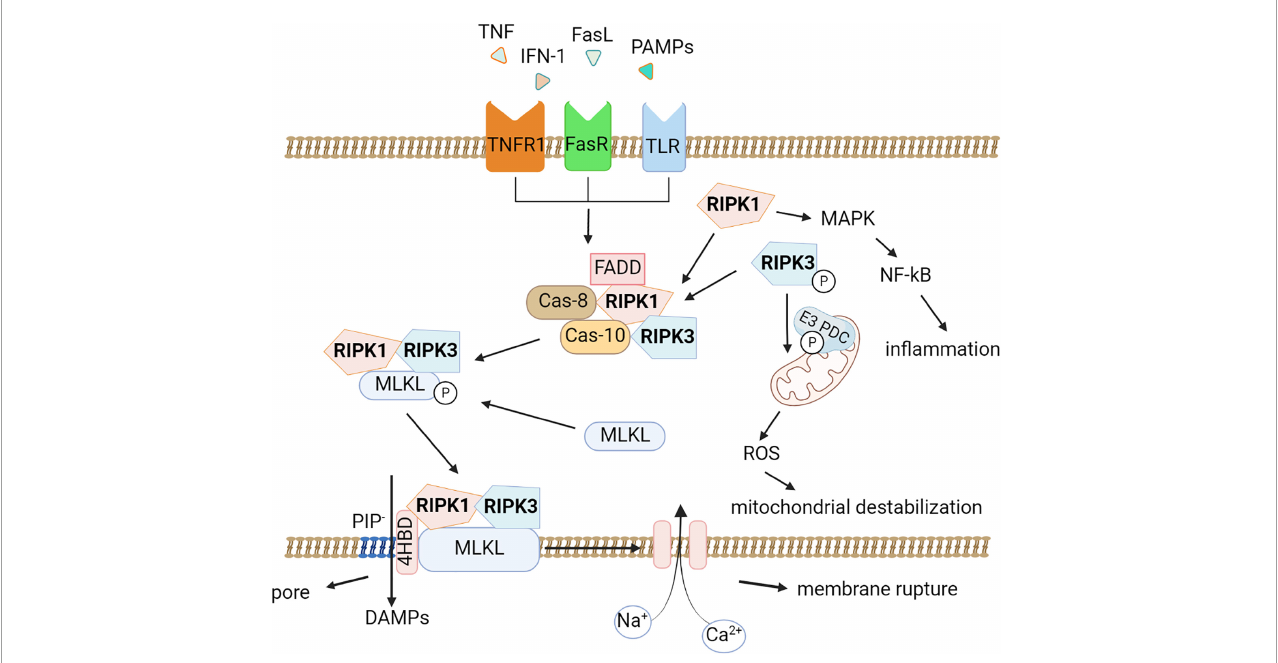
FIGURE1 Molecular pathways of necroptosis. Activation of the tumor necrosis factor receptor (TNFR1), death receptors, Toll-like receptors triggers necroptosis. An oligomeric complex including RIPK1, Fas-associated death domain protein (FADD), caspase-8, and caspase-10 is formed and if caspase-8 activity is absent, RIPK1 recruits and phosphorylates RIPK3 to form a ripoptosome complex. Further the RIPK1/RIPK3 complex recruits and phosphorylates MLKL, thereby forming necrosomes. MLKL forms pores in the plasma membrane through an interaction between a positively charged site in the 4-helical bundle domain (4HBD) and negatively charged phosphatidylinositol phosphates (PIP) present on the membrane then the cell dies. DAMPs (HMGB1, IL-1 α , ATP) can be released during this process. Also, necroptosis possibly leads to destabilization of mitochondria and the production of reactive oxygen species (ROS). RIPK1 promotes the expression of pro-inflammatory genes by activating the mitogen-activated protein kinase (MAPK) signaling pathway and the transcription factor NF- κ